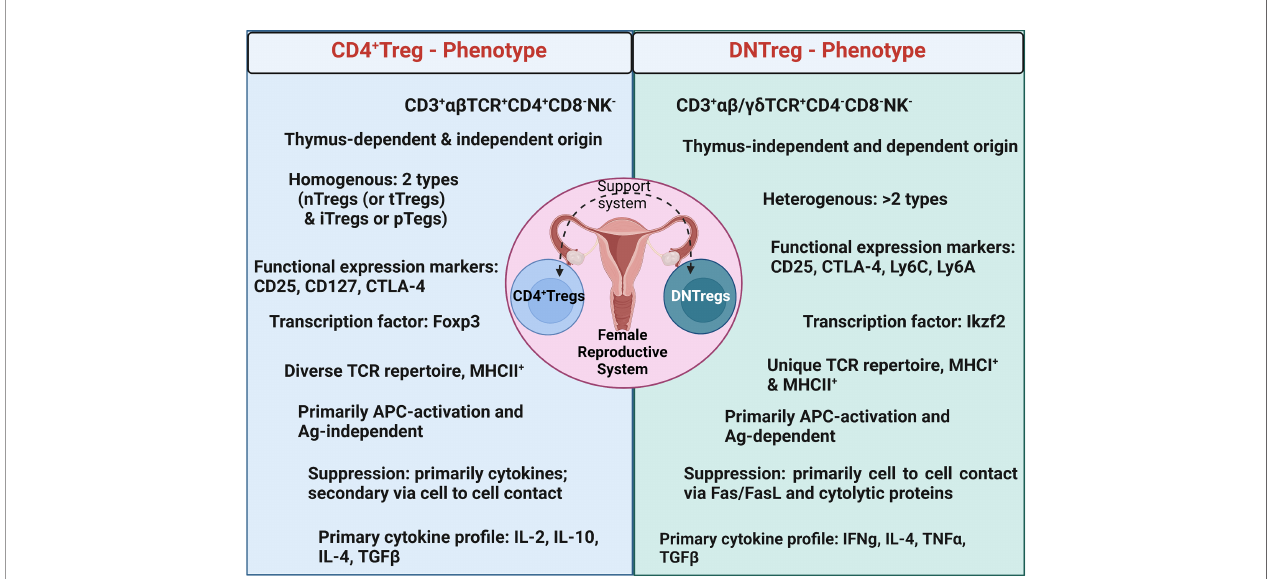
FIGURE 4 | Summary of major phenotypic characteristics of DNTregs compared to CD4 + Tregs. Ag = Antigen; nTregs= naturally occurring Tregs; tTregs= Tyhmic Tregs; iTreg = inducible Tregs; pTregs = peripheral Tregs. Figure created using Biorender.com